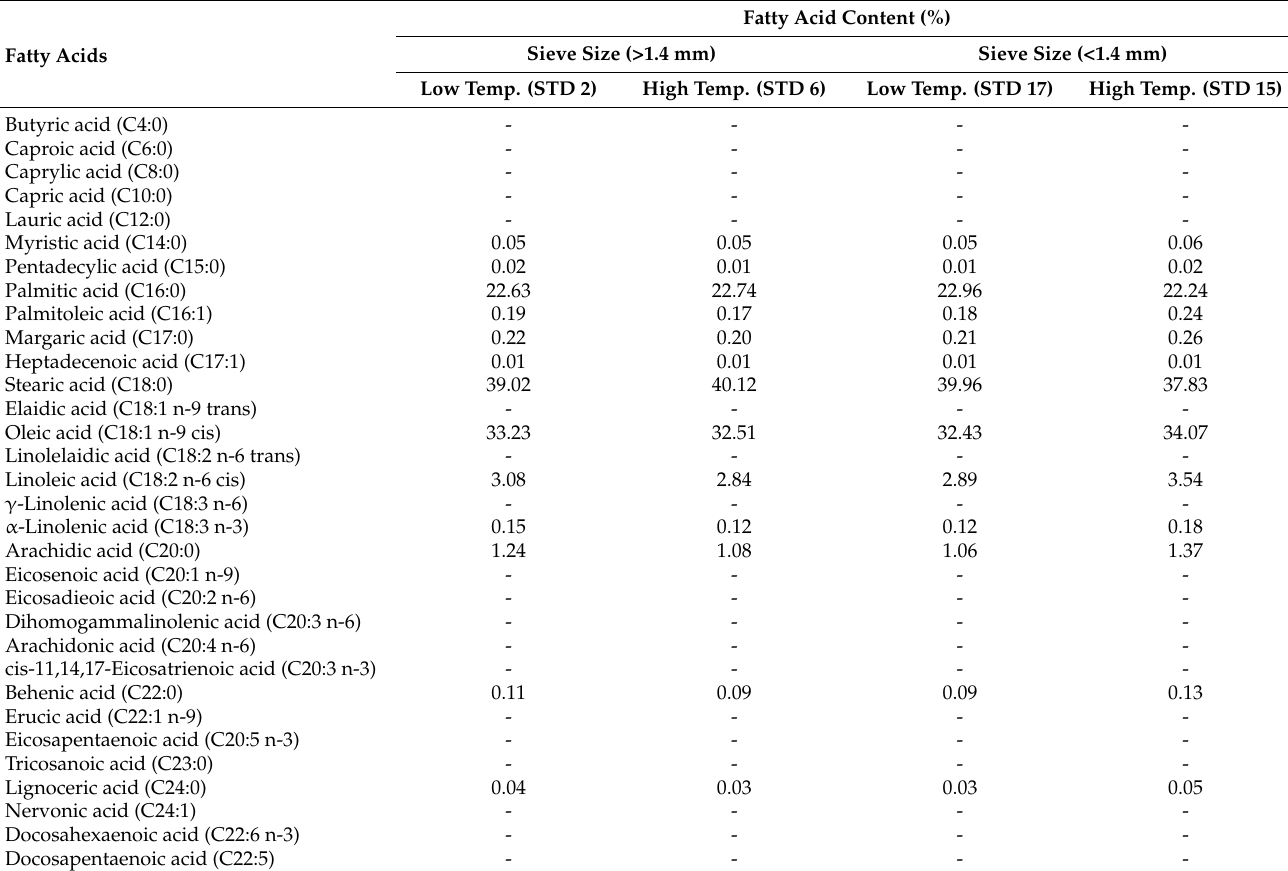
Table 5. The fatty acid content of representative CSO